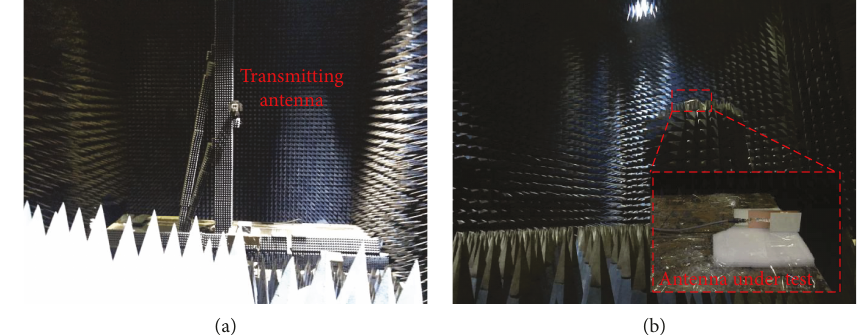
Figure 8: The far- fi eld radiation pattern measurement